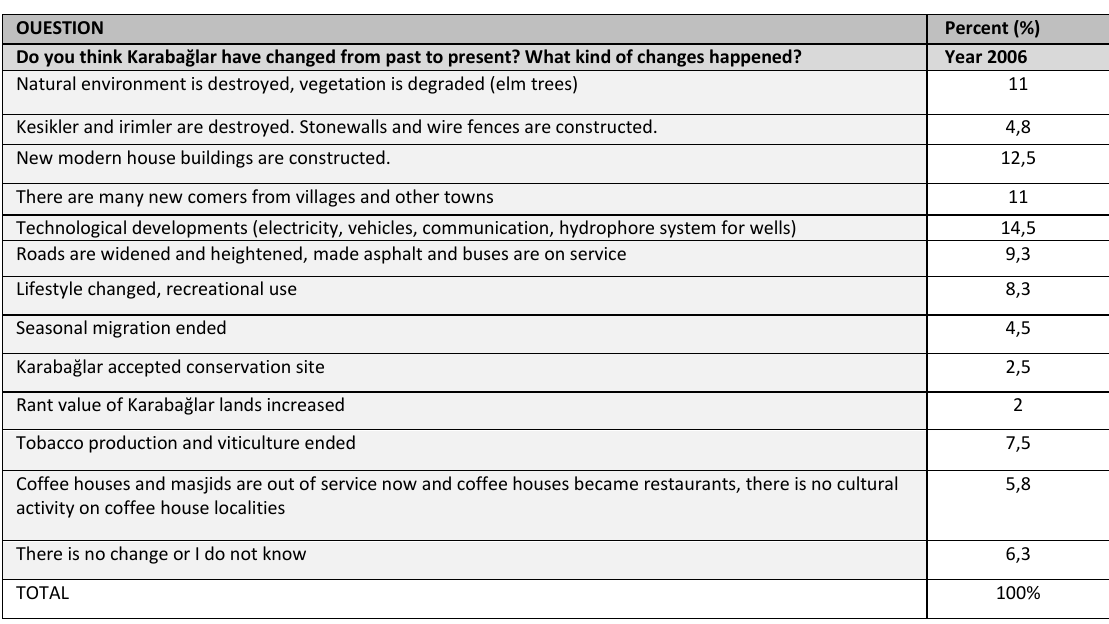
Table 4 Answers to the question: Do you think Karabağlar have changed from past to present? What kind of changes happened? OUESTION Percent (%)